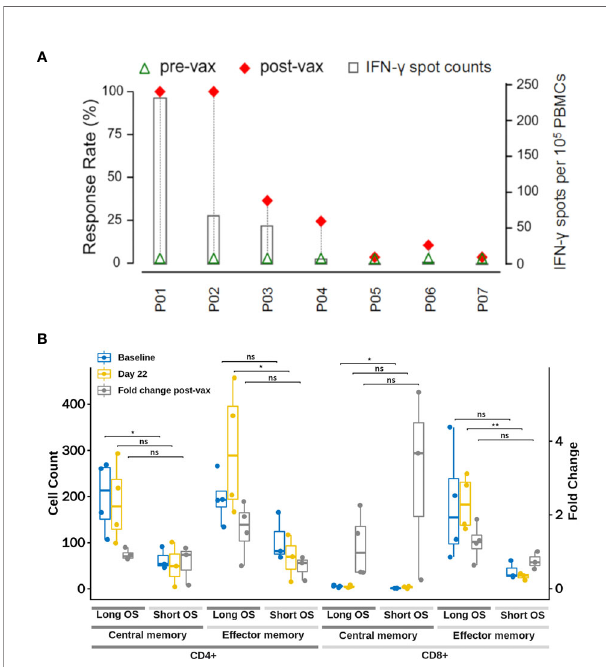
FIGURE 5 | The proportion of CTLA4+ T cells in peripheral blood increased after vaccination. The proportions of CD8+ CTLA-4+ T cells and CD4+ CTLA- 4+ T cells ratio to total T cells in peripheral blood were determined by fl ow cytometry. Fold changes of post vaccination compared with baseline were